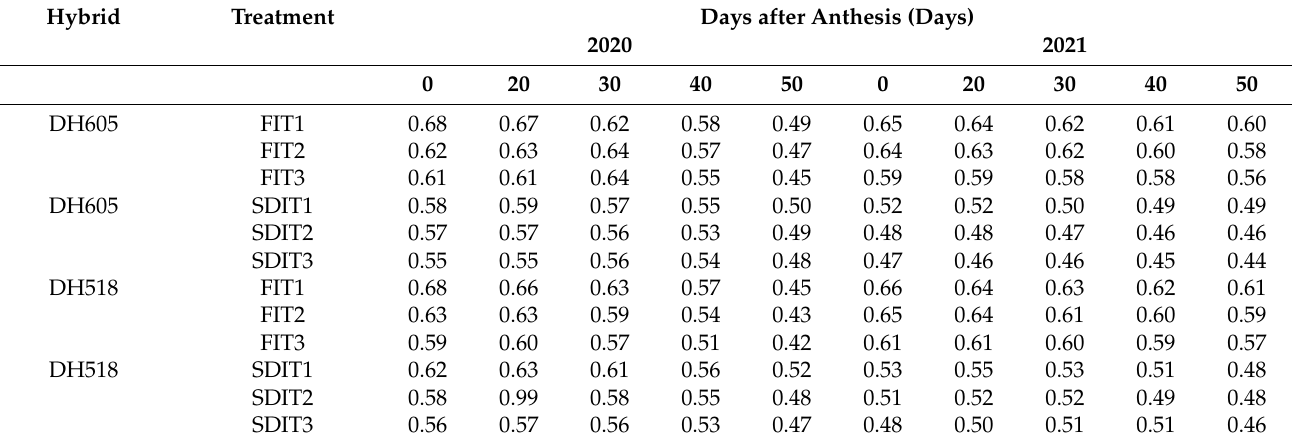
Table 9. The stomatal limitation value (L s ) of two corn hybrids differing in maturity under different irrigation